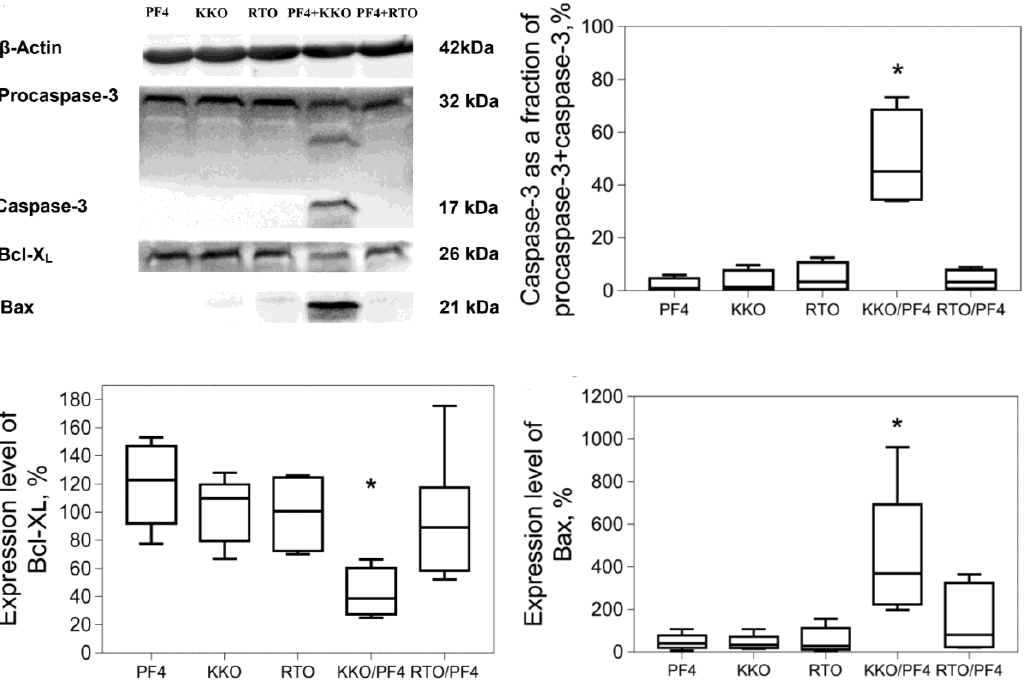
Figure 4. Western blot analysis of molecular markers of apoptosis [(pro)caspase-3, Bcl-X L , Bax] in platelet lysates obtained under various experimental conditions. Platelets were incubated for 60 min with 10 µ g / mL PF4, 50 µ g / mL KKO (pathogenic monoclonal anti-PF4 / heparin Ab), 50 µ g / mL RTO (non-pathogenic monoclonal anti-PF4 / heparin Ab), as well as KKO + PF4 and RTO + PF4 combinations. The figure shows representative Western blots and quantitative analysis of the molecular markers of apoptosis based on four experiments with platelets isolated from independent donors. The numbers that characterize the size and intensity of each band were normalized by the corresponding negative control (untreated platelets) taken as 100%. * p < 0.05 compared to RTO / PF4 (Kruskal–Wallis test with Dunn’s post-hoc test).